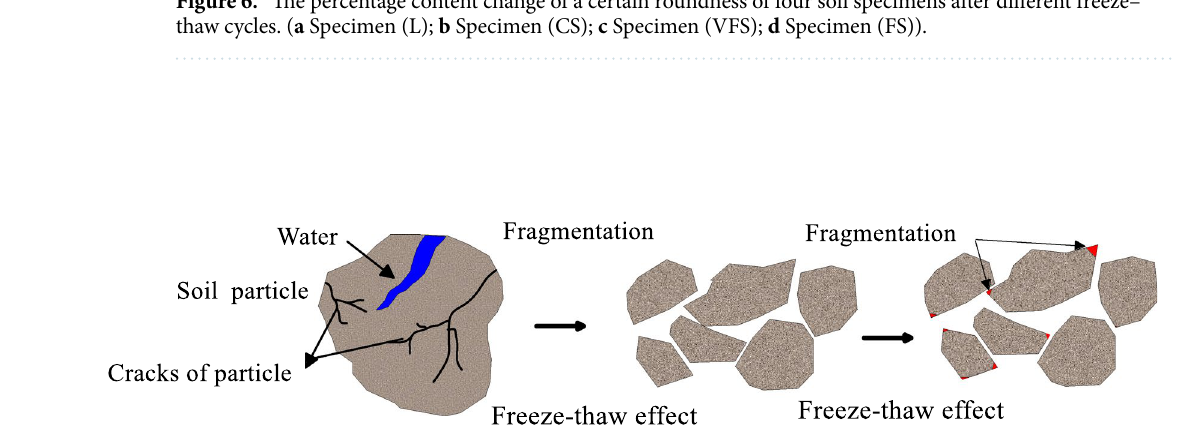
Figure 7. Conceptual diagram of the change in particles roundness due to freeze–thaw